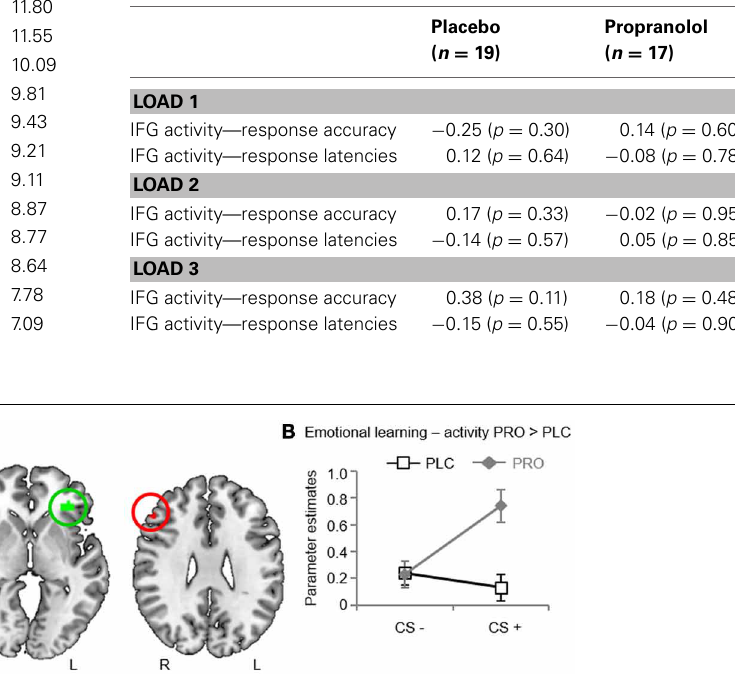
During emotional memory acquisition propranolol-treated subjects showed stronger activity in the right IFG. Plotting the individual extracted parameter estimates for the right IFG revealed this effect was driven by selective effects of propranolol on the CS + . Abbreviations: PLC, placebo; PRO, propranolol; IFG, inferior frontal gyrus; CS + , conditioned